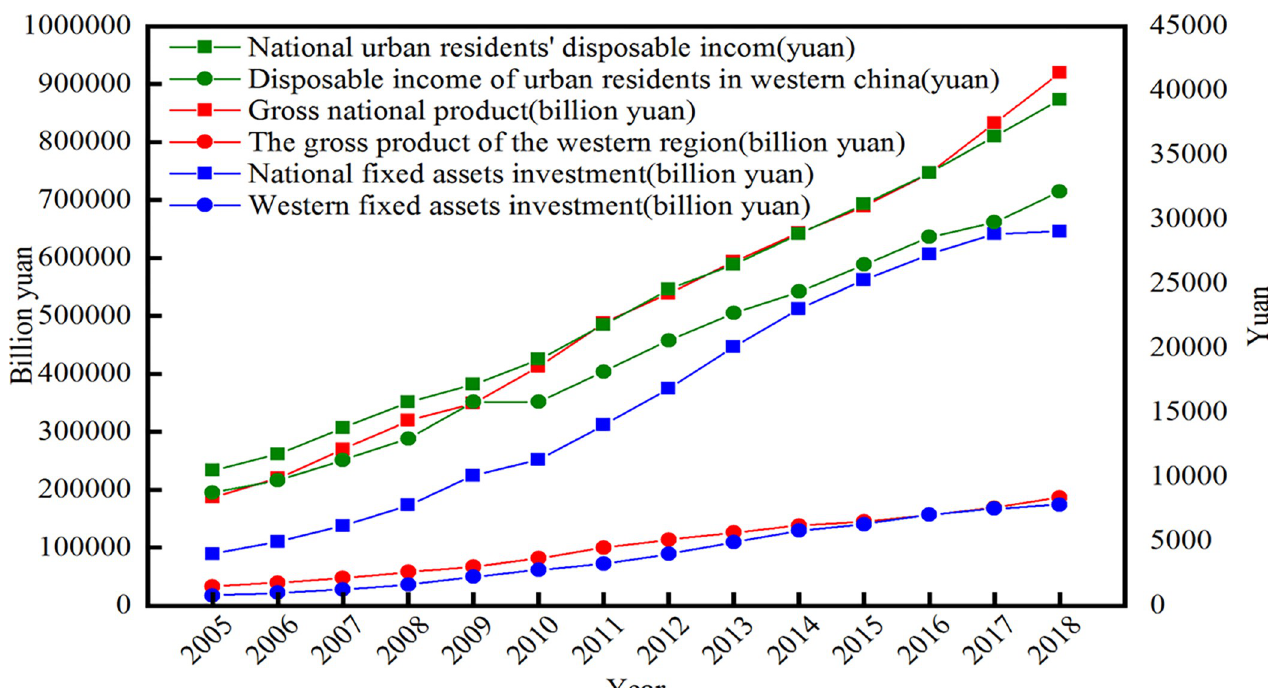
Fig 4. The economic development of the Eastern region from 2005 to